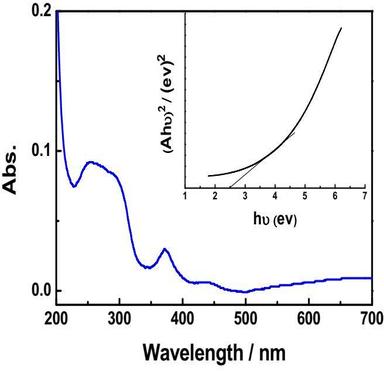
UV–Vis spectrum and energy gap of GO@TiO2.ZnO.Ag.